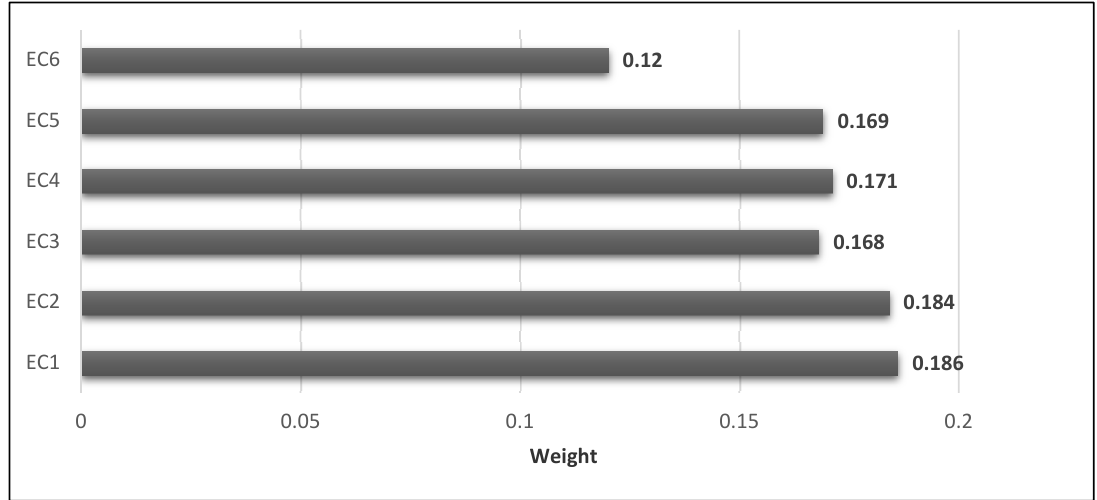
Figure 3. Ranking of green innovation sub-criteria with respect to the economic (EC) criteria. Processes 2020 , 8 , x